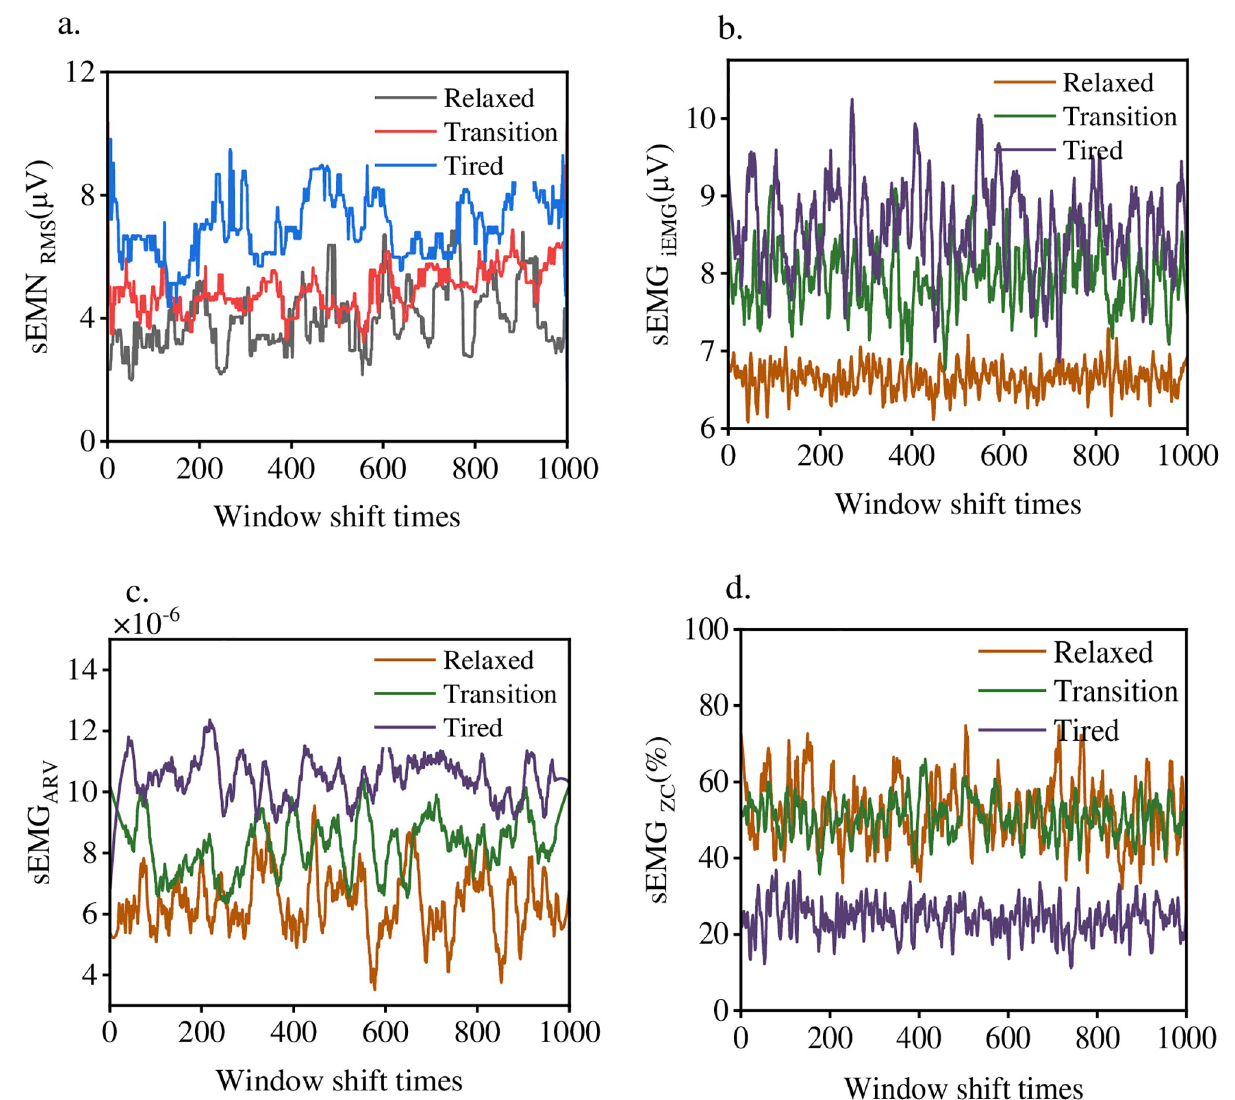
Fig 9. Time domain eigenvalue